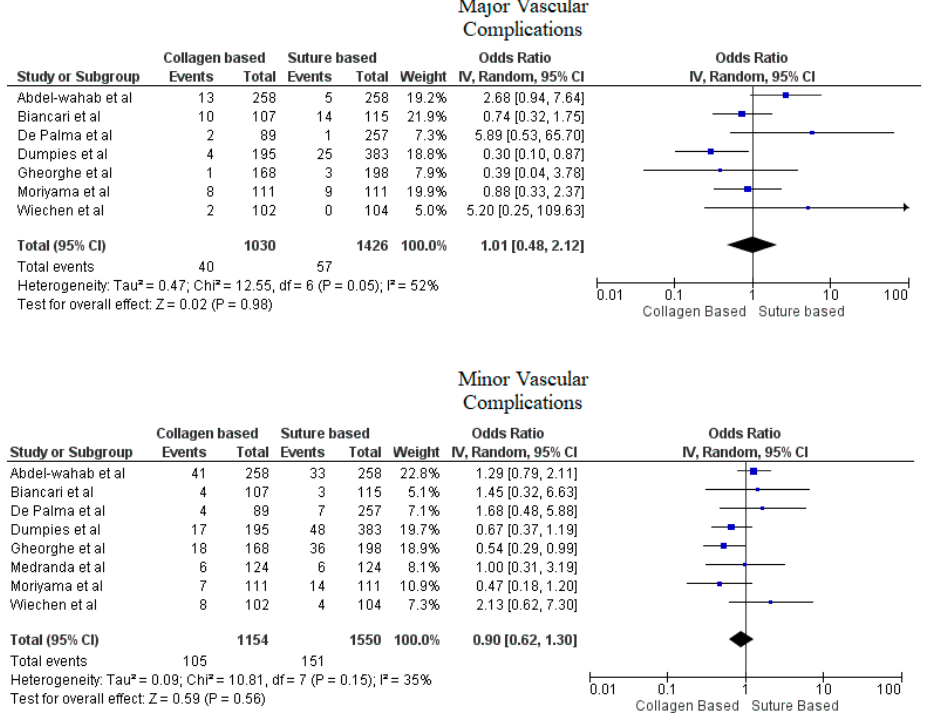
Figure 3. Forest plot for comparison of major and minor vascular complications between collagen vs. suture-based vascular closure devices for large bore arteriotomies, CI: confidence interval, IV: Instrumental variable.